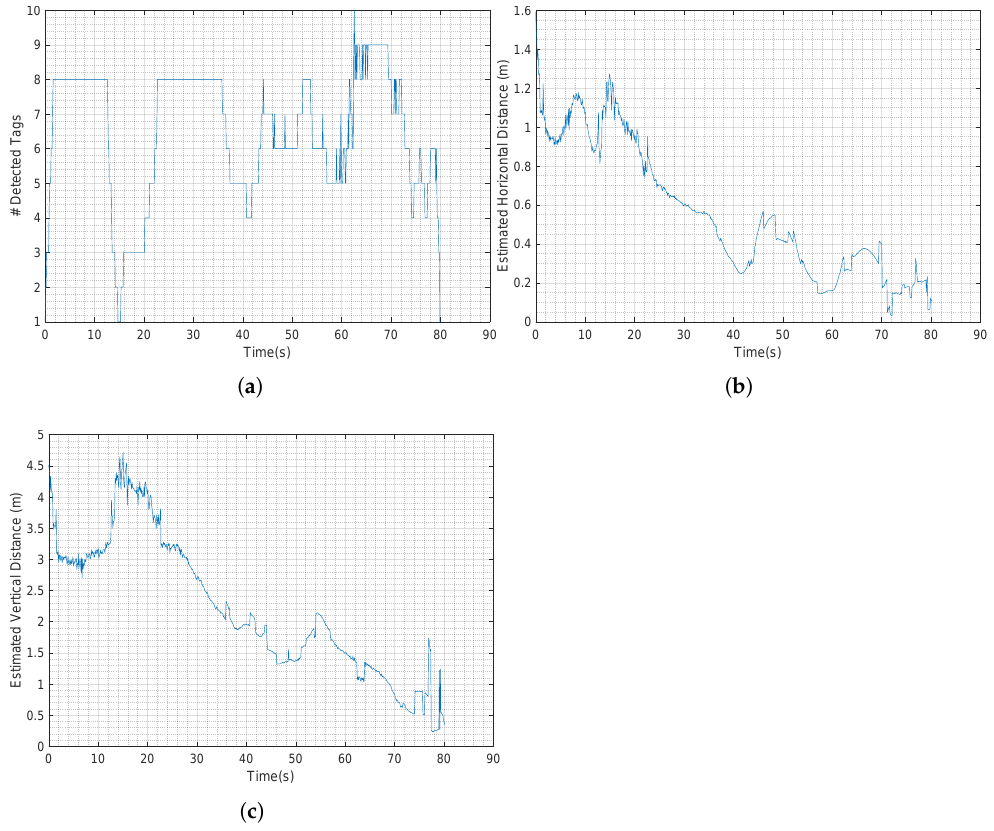
Figure 13. Evolution during manual landing experiment of: ( a ) number of tags detected; ( b ) horizon- tal error; ( c ) vertical